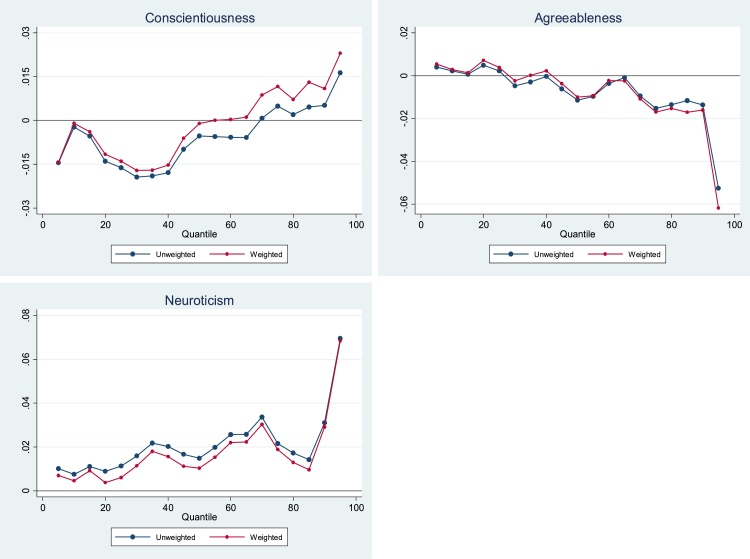
Weighted non-cognitive skills – Allostatic load relationship.